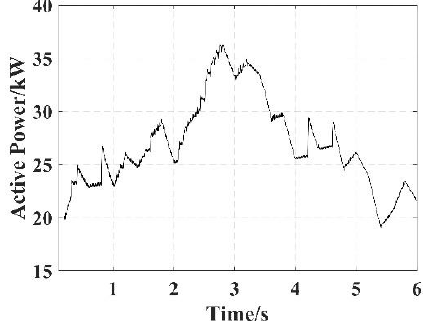
Figure 10. Photovoltaic active power fluctuation.